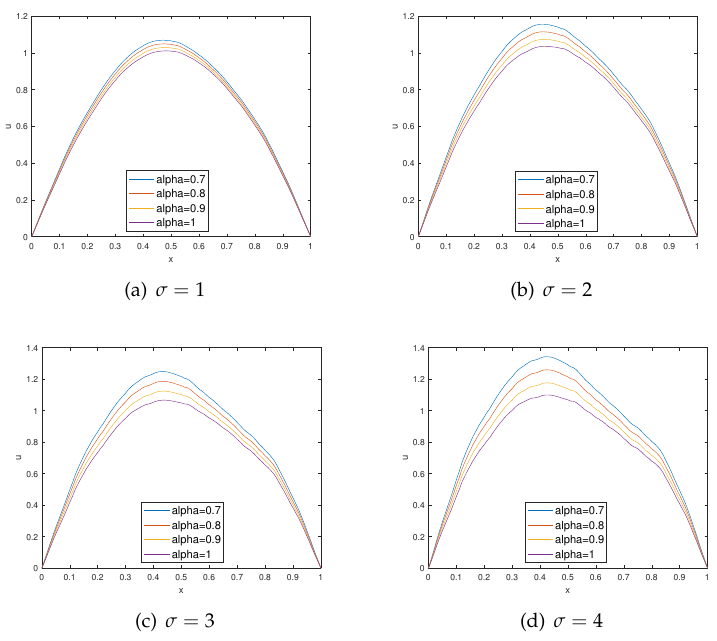
Figure 3. The approximation solutions of Example 1 with t =